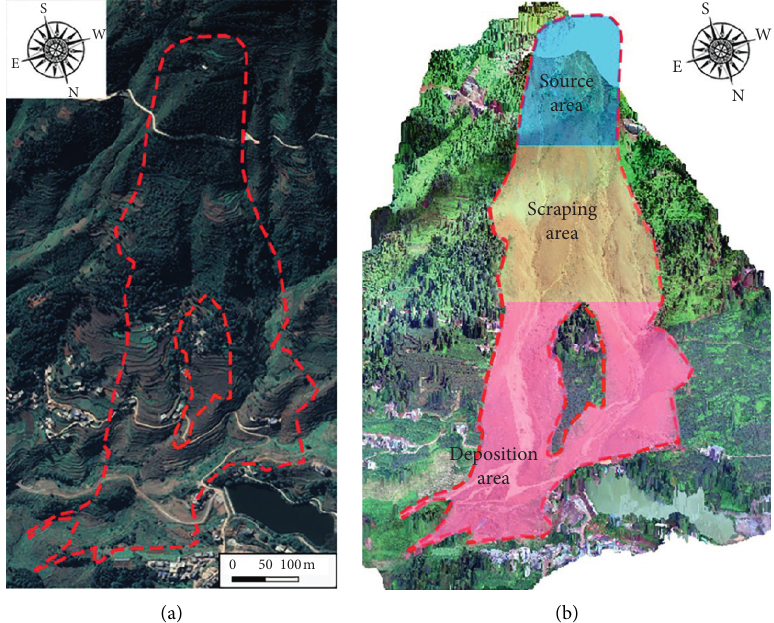
Figure 3: Comparison of (a) the presliding satellite photo from Google Earth and (b) the postsliding photo taken by the UAV of the Shuicheng